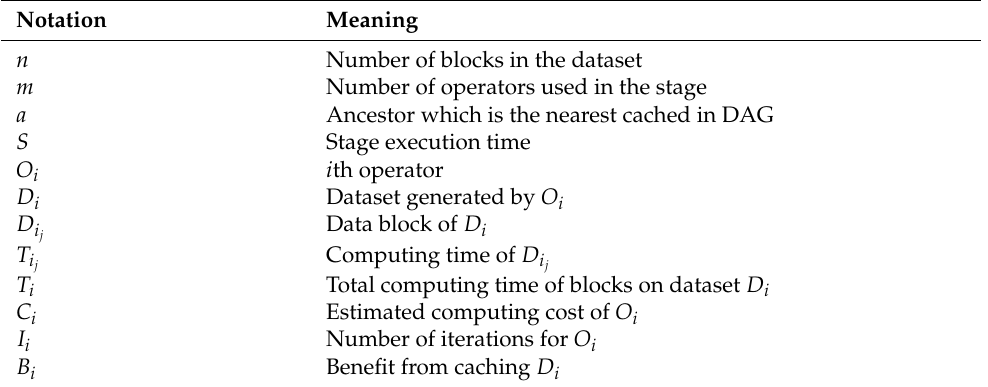
Table 1. Glossary of the